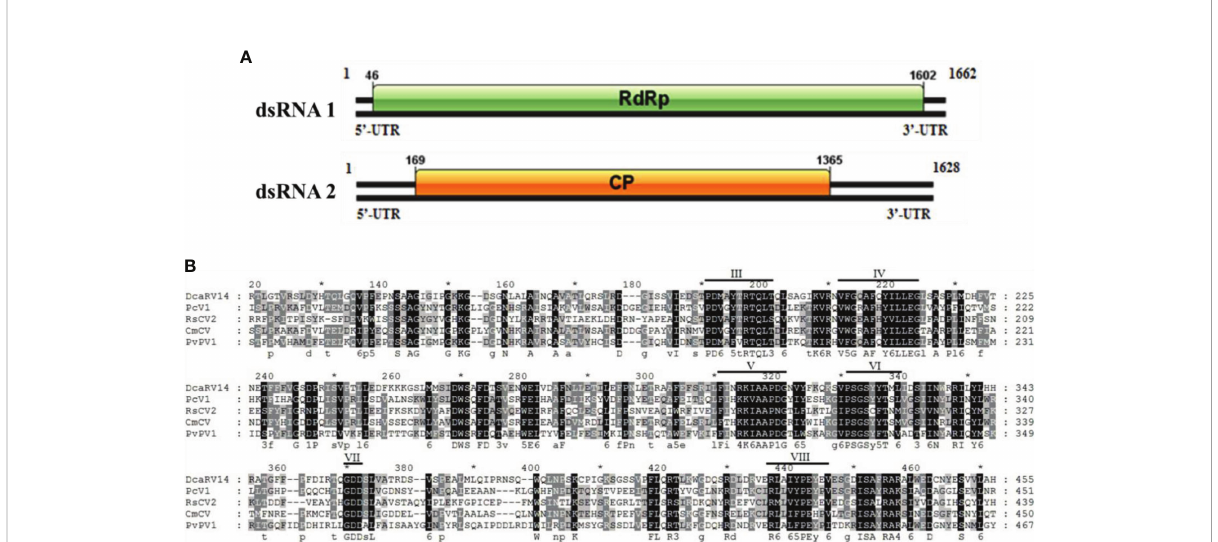
FIGURE 12 Diagrammatic representation of the genome organization of PvPV1. (A) Diagram showing the structure of PvPV1. The open reading frame (ORF) and the 5 ’ and 3 ’ untranslated regions (UTRs) are indicated by the colored long rectangular box and solid black lines, respectively. The initiation and termination codons of the ORF are indicated by the numbers under the solid lines. (B) Multiple alignment of the aa sequences of RdRp domains of PvPV1 and other similar deltapartitiviruses using the ClustalX program and highlighted using the GeneDoc program. The conserved motifs in these RdRps are indicated by Roman numerals III to VIII. Virus names and accession numbers are as follows: DcaRV14, diatom colony- associated dsRNA virus 14 (AP014906); PcV1, pepper cryptic virus 1 (AVV48358); RsCV2, Raphanus sativus cryptic virus 2 (ABB04855); CmCV, Cucumis melo cryptic virus